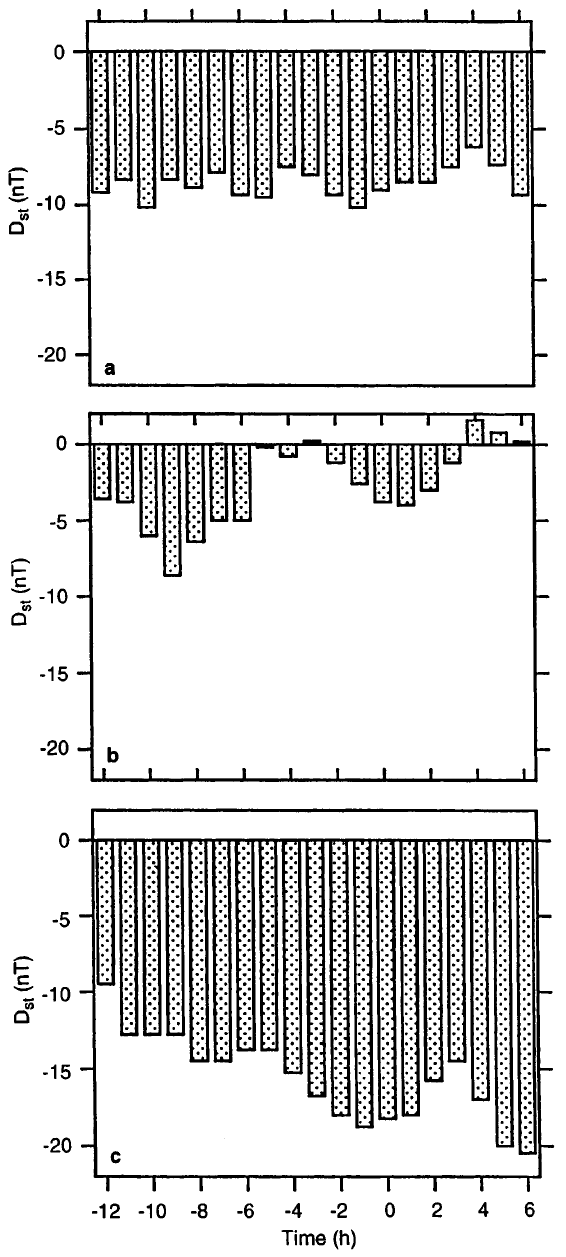
Fig. 5a–c. The results of a superposed epoch analysis of the Dst index during a the correlated (resonant) events described in Paper 1 (see main text), and the b dawn and c postnoon populations of uncorrelated waves